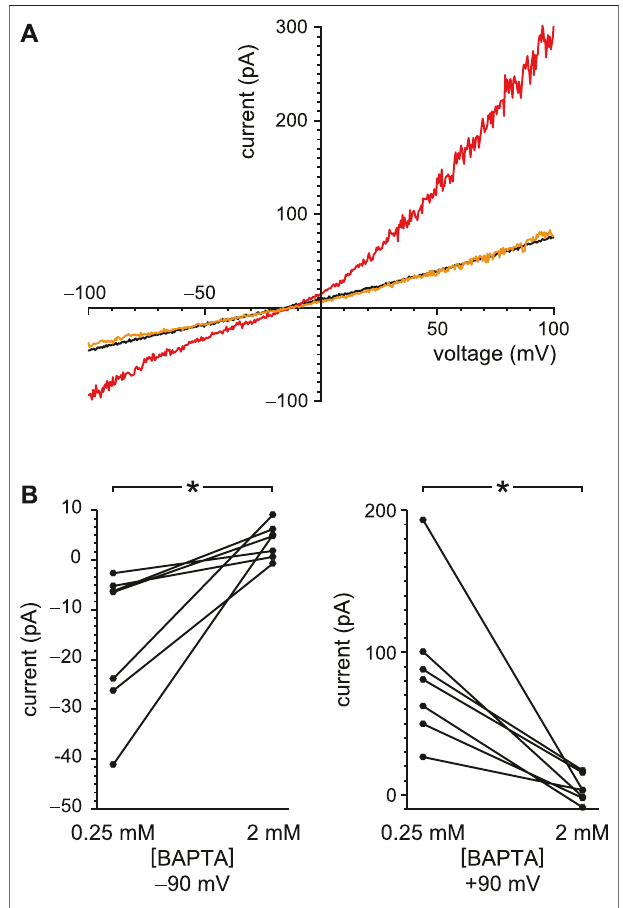
FIGURE 8 | Steady-state TRPV4 activity is greater with reduced Ca 2+ buffering (0.25 mM BAPTA compared to 2 mM BAPTA). (A) In a single cilium, the current-voltage relation was measured with 0.25 mM BAPTA (black), in the same solution after addition of the TRPV4 agonist GSK1016790A (50 nM, red), and in a solution with 50 nM GSK1016790A but with BAPTA increased to 2 mM (orange). (B) Paired currents activated by 50 nM GSK1016790A in 10 cilia, each tested in both 0.25 mM BAPTA and 2 mM BAPTA. The left plot shows current at − 90 mV and the right at +90 mV * p = 0.0016 at both